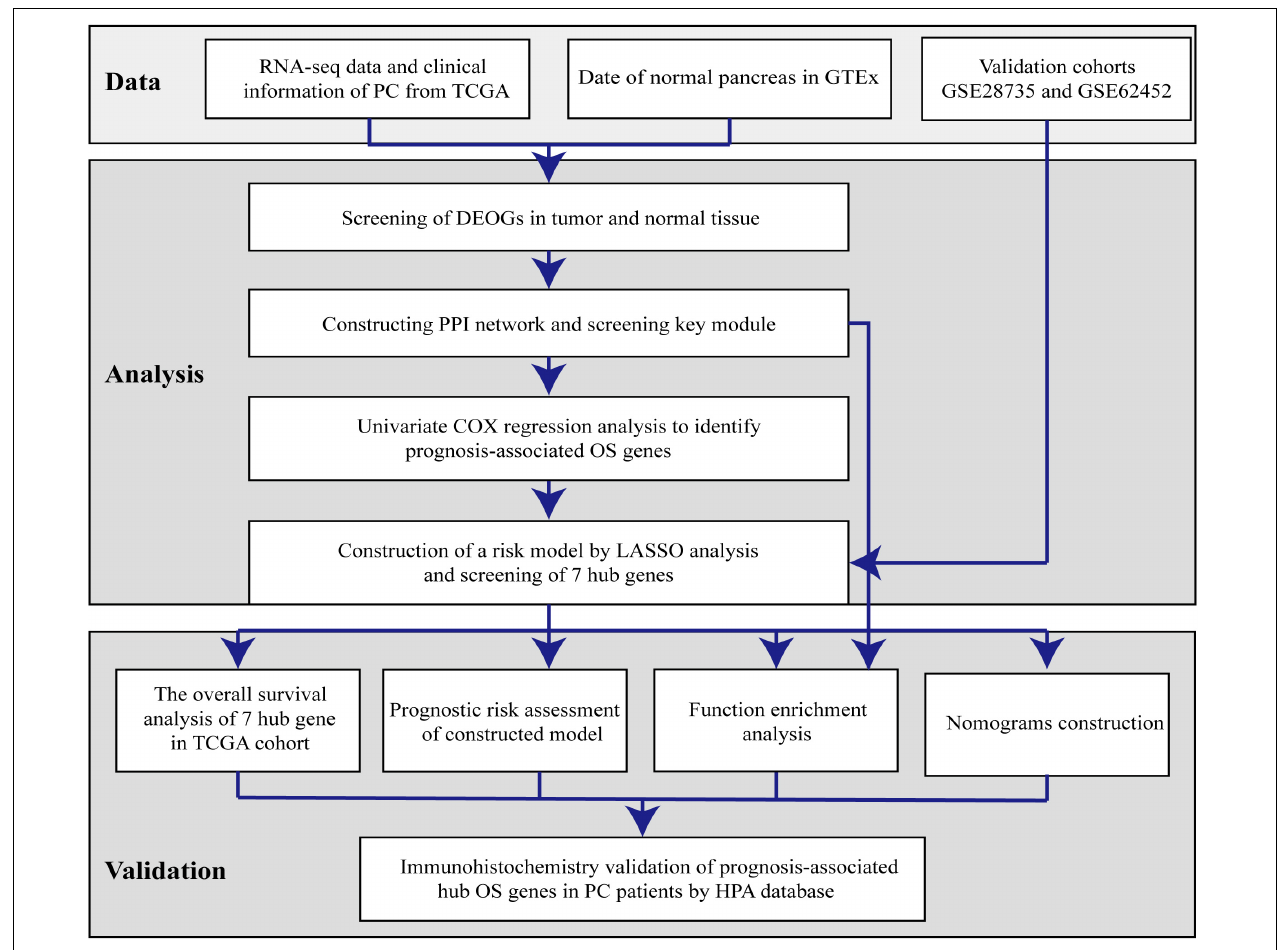
FIGURE 1 | Flowchart describing the schematic overview of the study design.